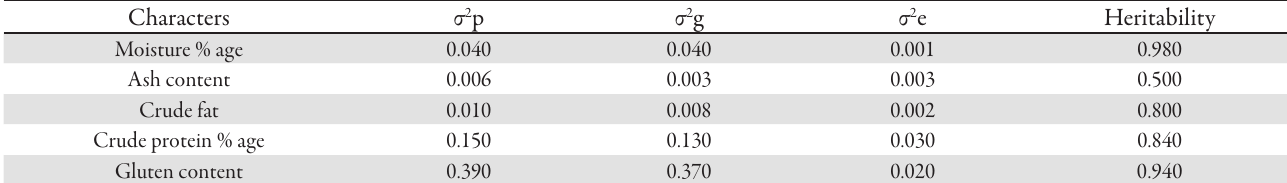
Tab. 5. Estimates of phenotypic variance ( σ 2p), genotypic variance ( σ 2g) and broad sense heritability under water stress conditions